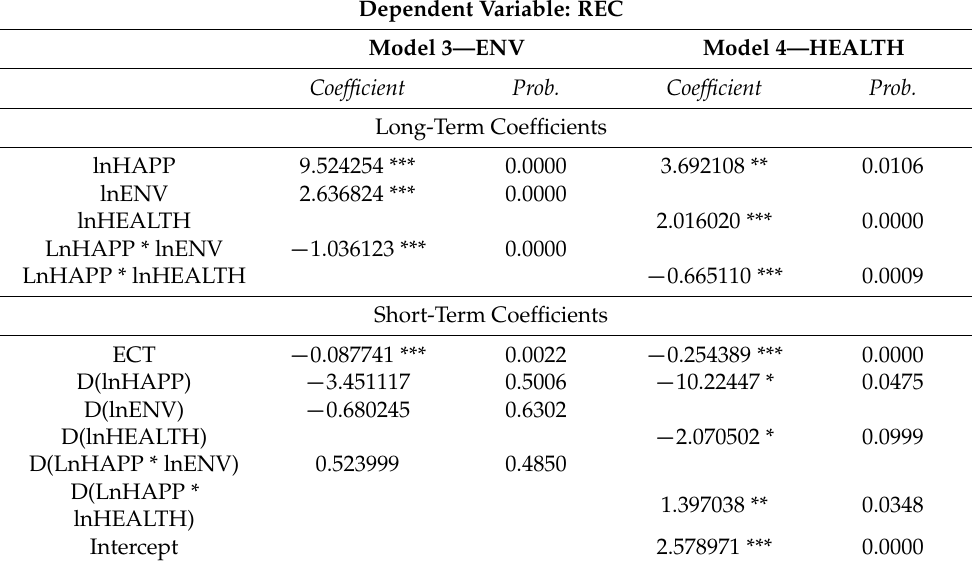
Table 7. ARDL panel estimation. REC—endogenous